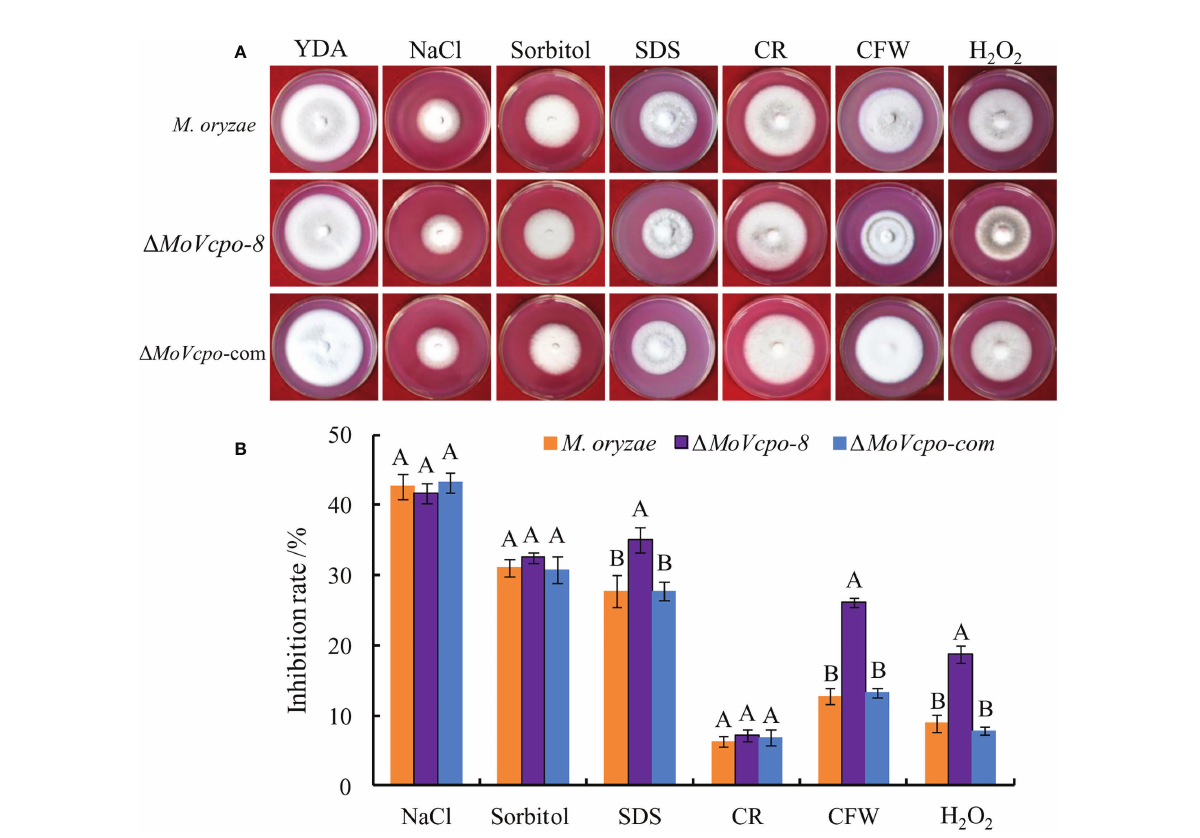
FIGURE 8 MoVcpo deletion affects various stress response of M. oryzae. (A) Colony morphology of the wild type, D MoVcpo -8, and D MoVcpo -com supplemented with different stressors on YDA plates. YDA, yeast-extract dextrose agar medium; CR, Congo red. CFW, calco fl uor white. (B) The inhibition rate was calculated by comparing the colony diameter on treatments with that of YDA without treatment. The inhibition rate (%) = [(diameter of untreated colony - diameter of treated colony)/diameter of untreated colony] × 100. Data are mean ± SE from three independent replicates. Different letters indicate signi fi cant difference at p <0.01 level by Duncan ’ s new multiple range